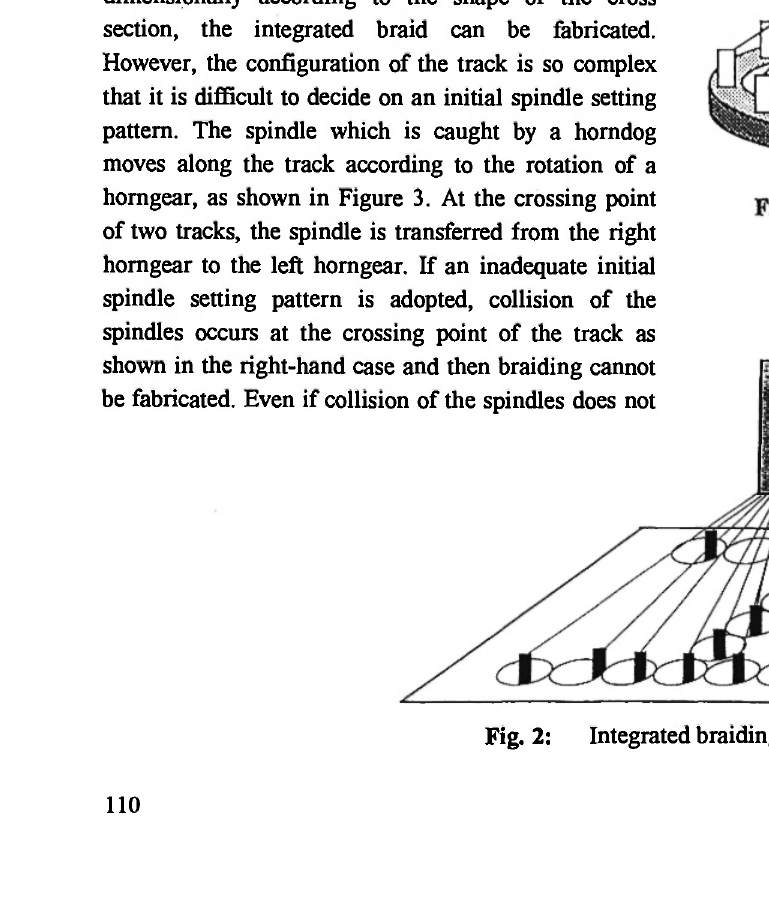
Fig. 2: Integrated braiding